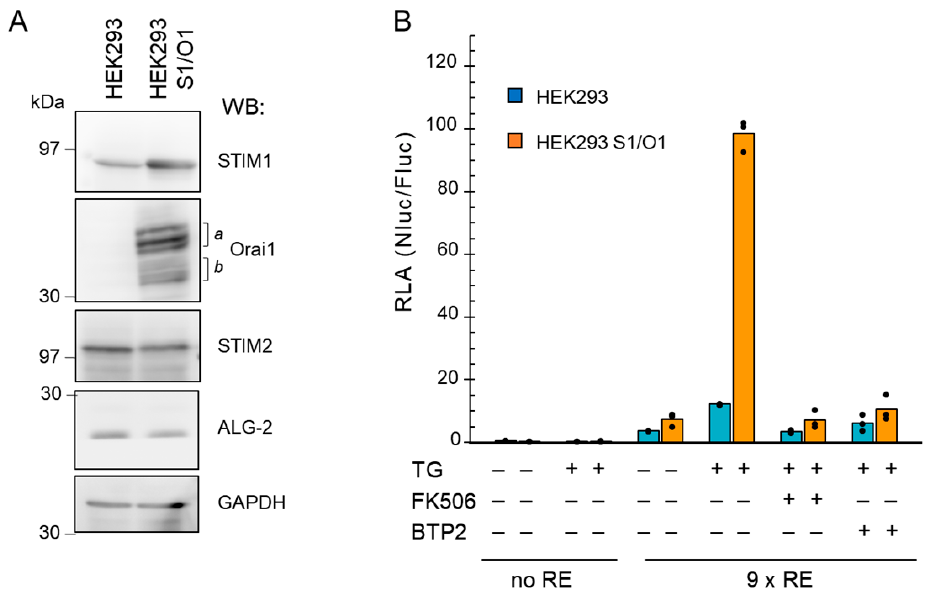
Figure 3. Detection of the NanoLuc reporter activity by endogenous NFAT in HEK293 cells depending on Ca 2+ -influx through CRAC channels. ( A ) HEK293 cells stably expressing human STIM1 and Orai1 (HEK293 S1/O1) were established by the retrovirus vector system as described in the Materials and Methods. Total lysates of the parental HEK293 and S1/O1 cells were analyzed by Western blotting (WB) with antibodies against STIM1, Orai1, STIM2, ALG-2, and GAPDH (used as a loading control), respectively. Multiple bands indicated by half-square brackets a and b probably